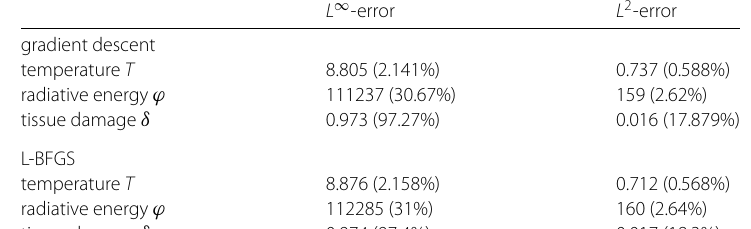
Table 4 Comparison between the simulated and measured temperature for a single measurement